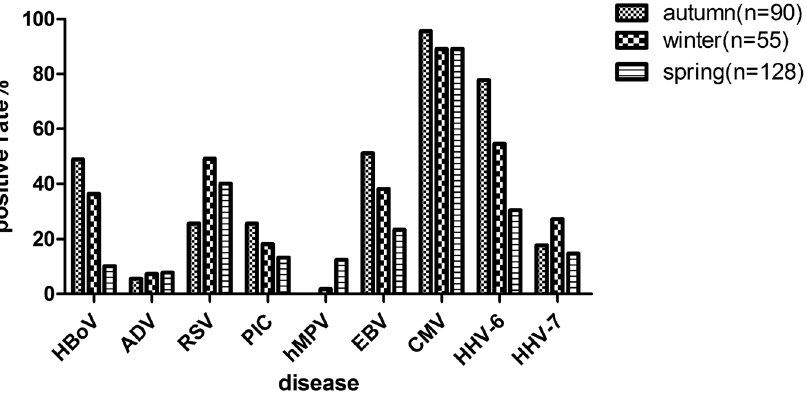
Figure 2. Seasons distribution of dominant viruses in IS samples of CAP patients from September of 2007 to April of 2008(Autumn: Sep. to Oct. of 2007; Winter: Nov. of 2007 to Jan. of 2008; Spring: Feb. to Apr. of